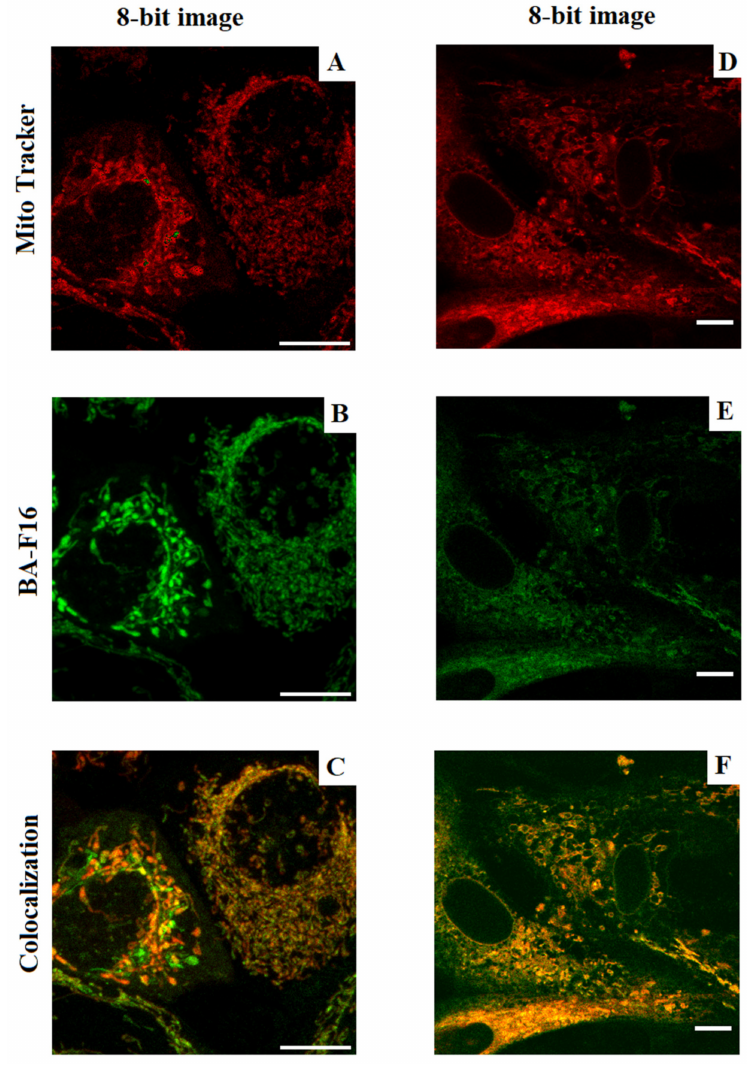
Figure 4. Evaluation of the mitochondrial localization of compound BA–F16 in MCF-7 breast ade- nocarcinoma cells ( A – C ) and human fibroblasts ( D – F ) by confocal microscopy. ( A , D ) MitoTracker Red fluorescence intensity image (200 nM, ( λ ex/ λ em) = 638/650 nm), ( B , E ) F16 fluorescence intensity image (200 nM, ( λ ex/ λ em) = 450/550 nm), ( C , F ) image obtained by overlaying images “A” and “B”, “D” and “E”. Scale bars: 10 µ